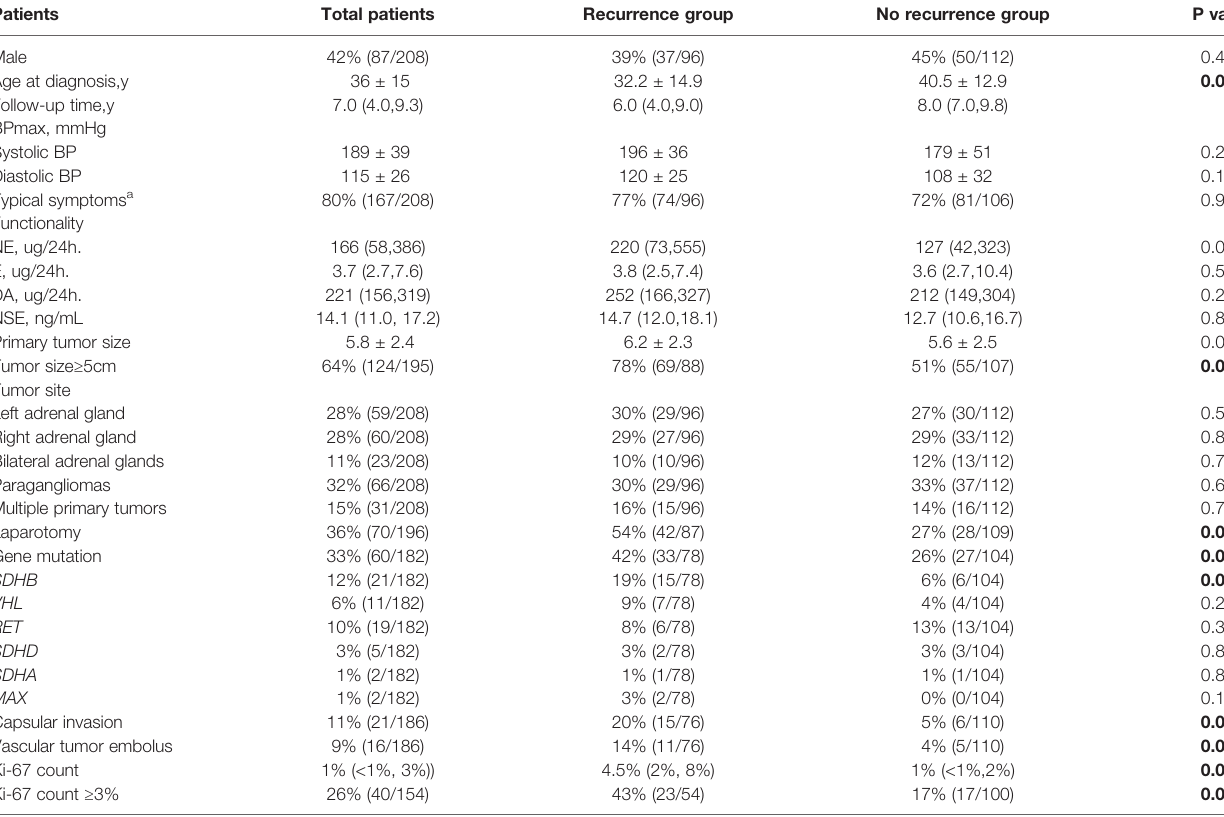
TABLE 1 | Differences in clinical characteristics between pheochromocytoma/paraganglioma patients with and without recurrence. Patients